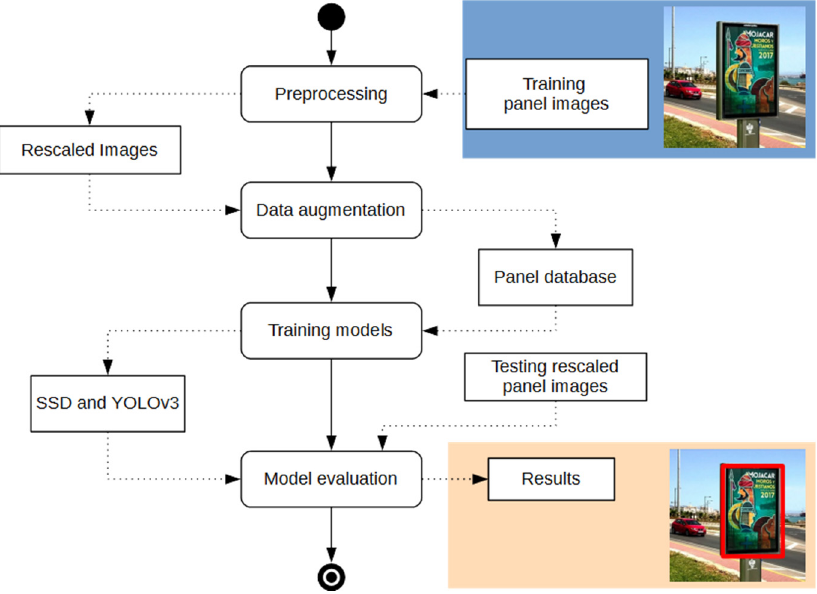
Figure 4. Overview of proposed method for panel detection.